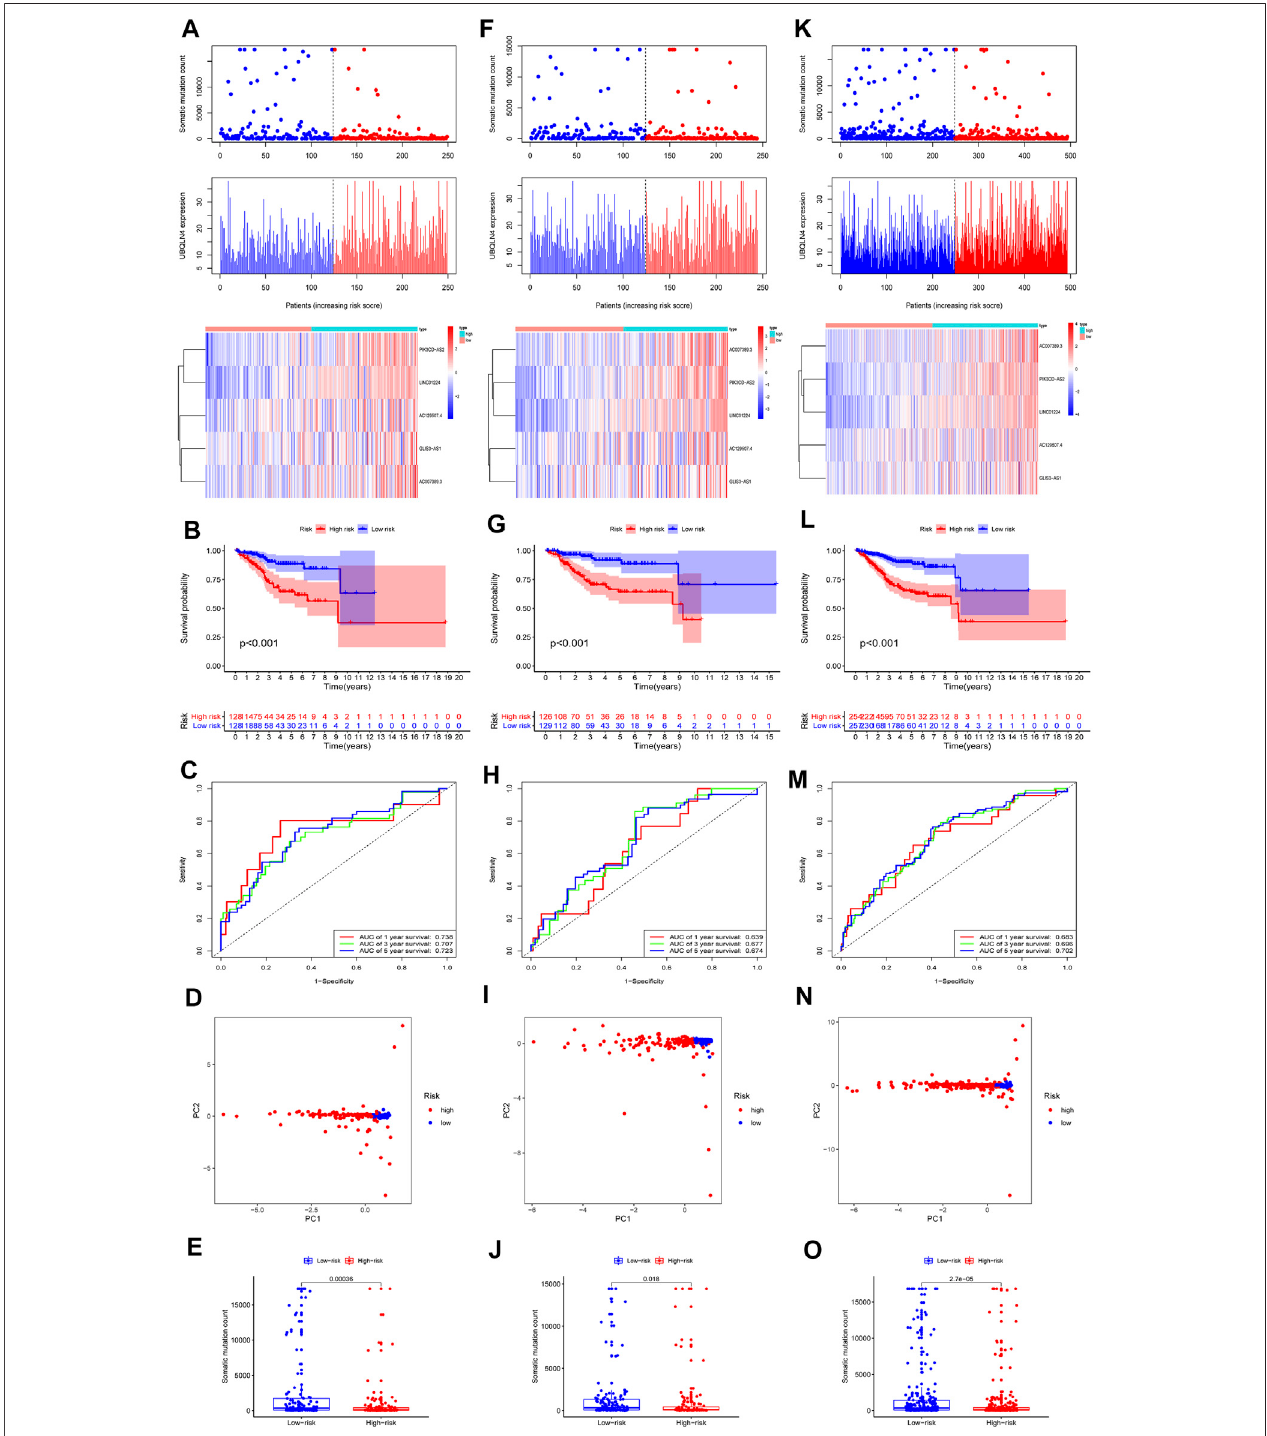
FIGURE3| ConstructionoftheGILncSigforprognosticprediction modelofgenomicinstability-relatedlncRNA.Intrainingset, (A) distributionofsomaticmutation, theexpression levelofUBQLN4 and fi velncRNAsexpression patterns astheriskscoreincreased. (B) Prognosticpredictioninthehigh-riskgroupandlow-riskgroupby Kaplan – Meier. (C) Time-dependent ROC curves were used to verify the survival prediction model. (D) PCA analysis revealed the difference between the high- and low-riskgroups. (E) Levelofsomaticmutationcountinthehigh-andlow-riskgroups.GILncSigevaluationinthetestingset. (F) Distributionofsomaticmutationand expression level of UBQLN4 as well asexpression patterns of fi ve lncRNAs as the risk score increased. (G) Prognostic prediction in the high- group and low-risk groups by Kaplan – Meier. (H) Time-dependent ROC curves were used to verify the survival prediction model. (I) PCA analysis revealed the difference between the high- and